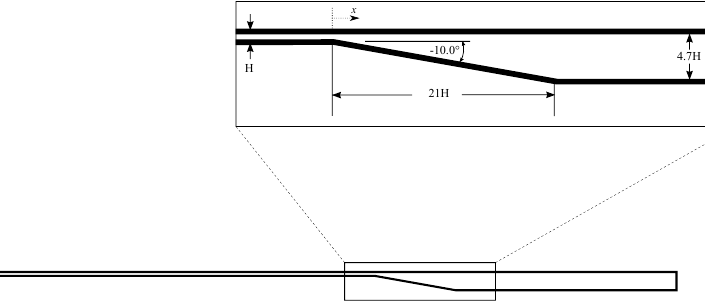
Version April 28, 2022 submitted to Appl. Sci.